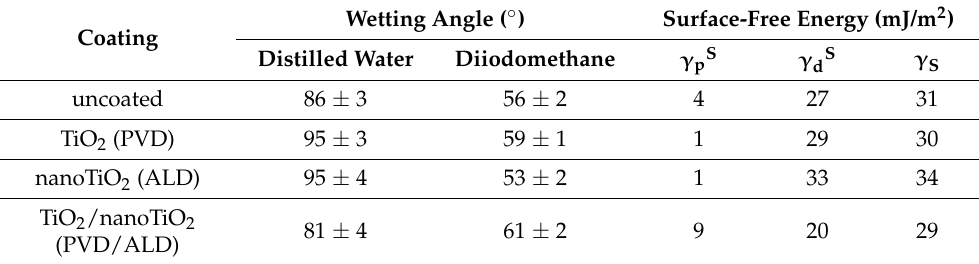
Table 4. The contact angle measurements and the surface energy calculated by the Owens–Wendt method.